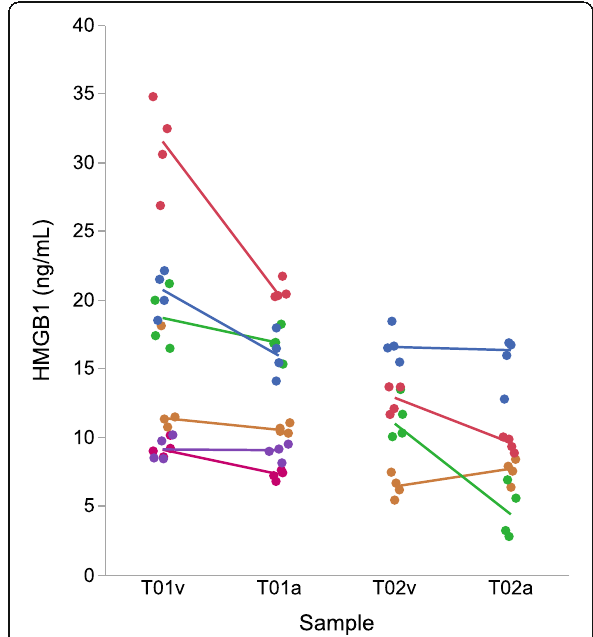
Fig. 3 Raw data plot of simultaneously acquired arterial and venous samples. Horizontal axis is marked with venous (v) and arterial (a) samples at T01 (admission) and T02 (approximately 2 h after admission, see text). All samples were analyzed in quadruplicate with results reported as median concentrations. Samples from individual patients are color coded, with a solid line between simultaneously obtained median venous and arterial HMGB1